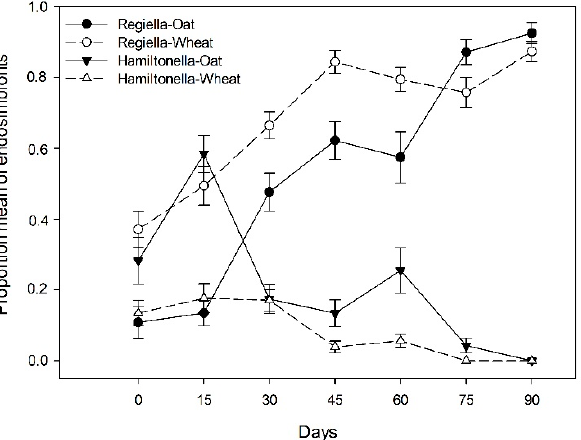
Figure 3. Mean proportion of infected aphids with facultative endosymbionts R. insecticola and H. defensa on wheat and oat across one season.